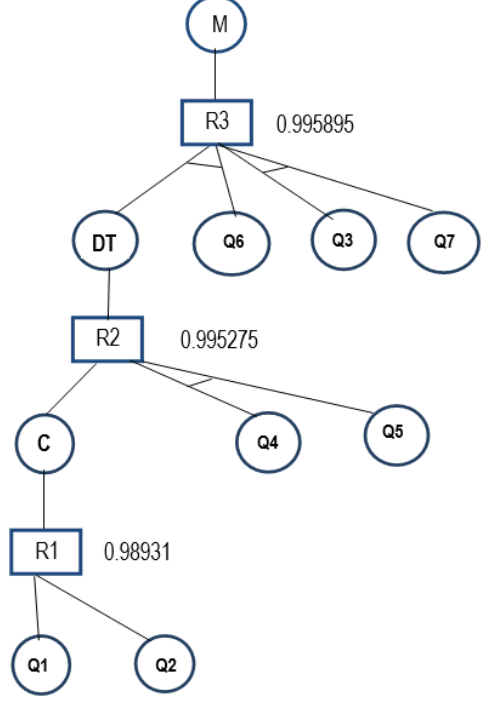
Figure A2. Decision tree for three production